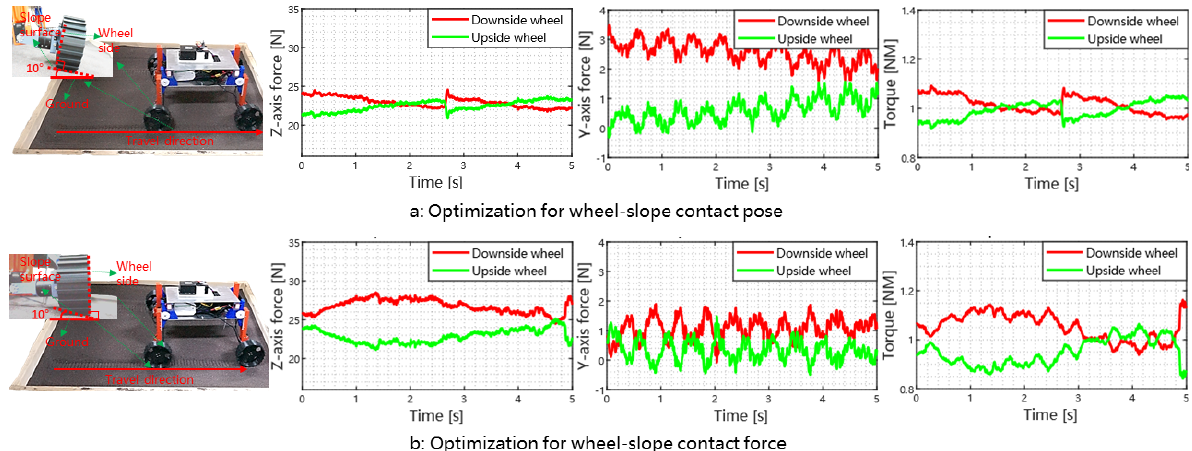
Figure 8. The rover trajectory and force/torque data (expressed in wheel frame ∑ C ) for different optimization objectives in the fine adjustment process. The first column shows the experimental scenarios, and the wheel-terrain contact states are shown as sub-figures ( left - top ) in detail. The last three columns show the force and torque information of the wheel during the traversing